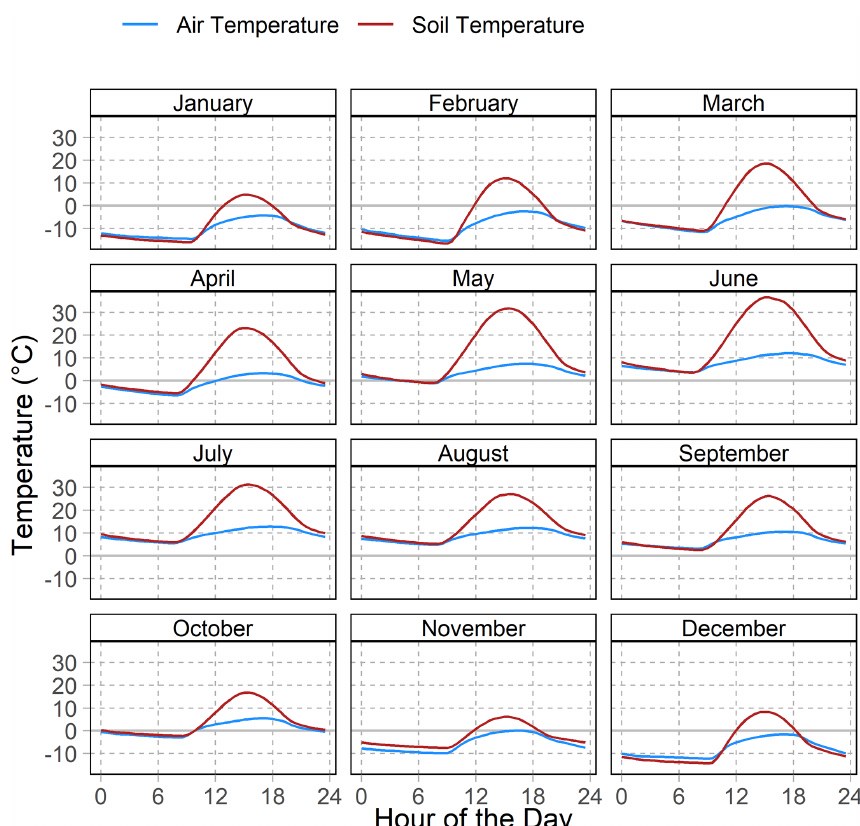
Figure A2. Monthly mean daily course of air and soil temperatures of the years